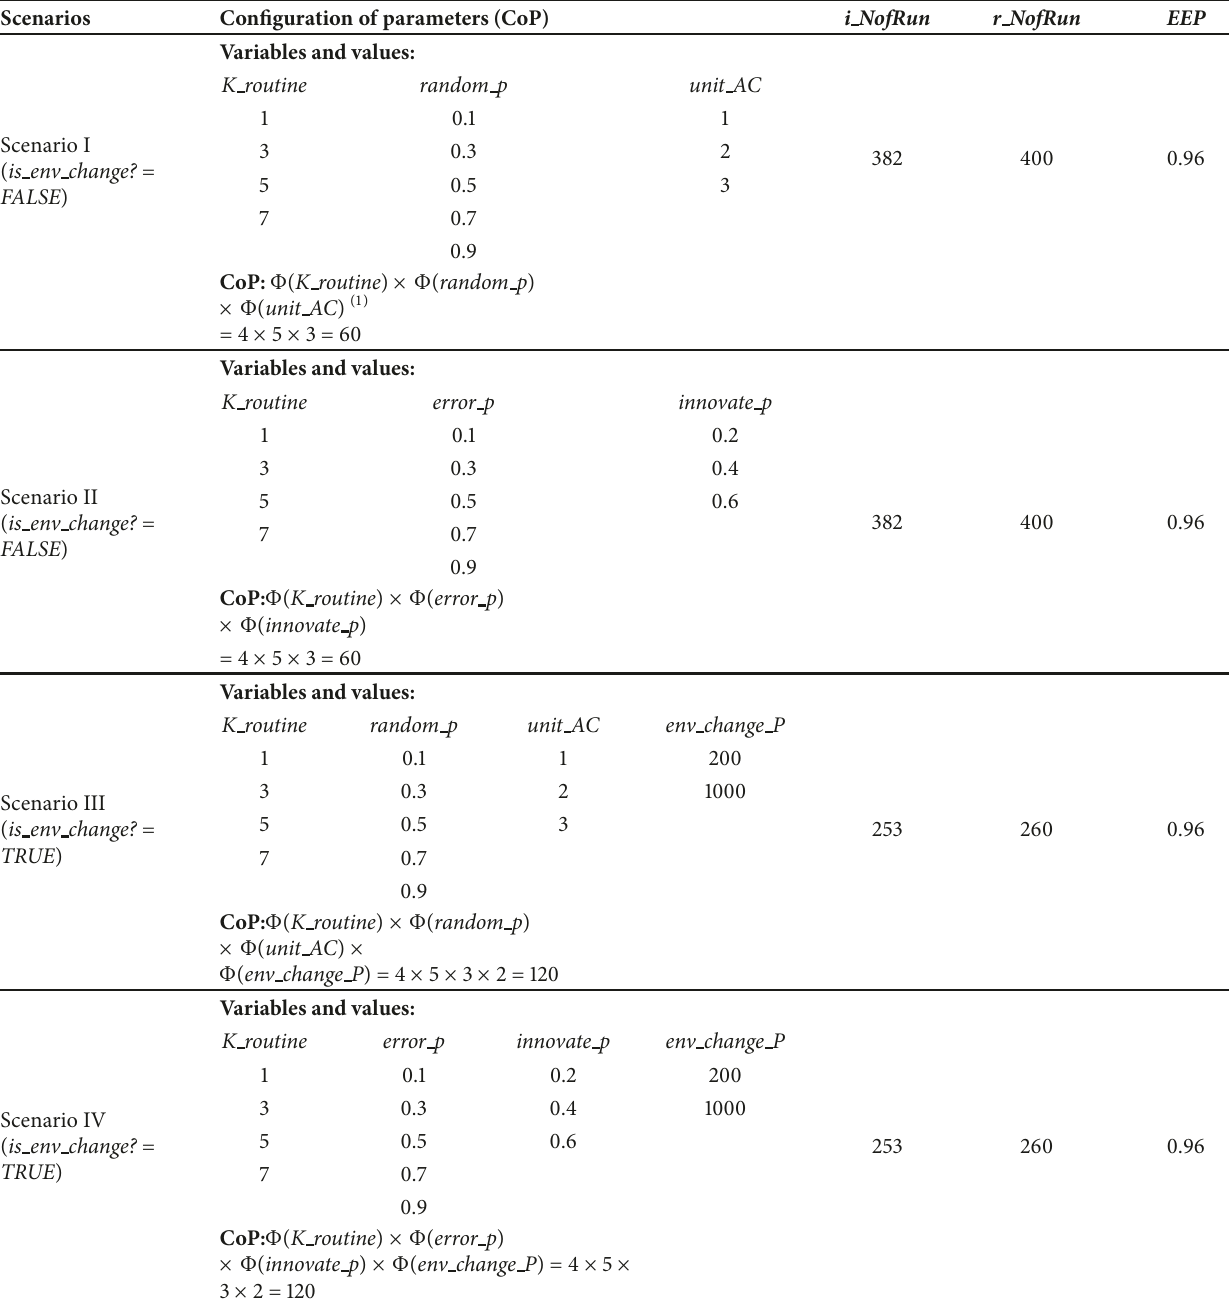
Table 3: Calculating running times needed for each scenario based on power